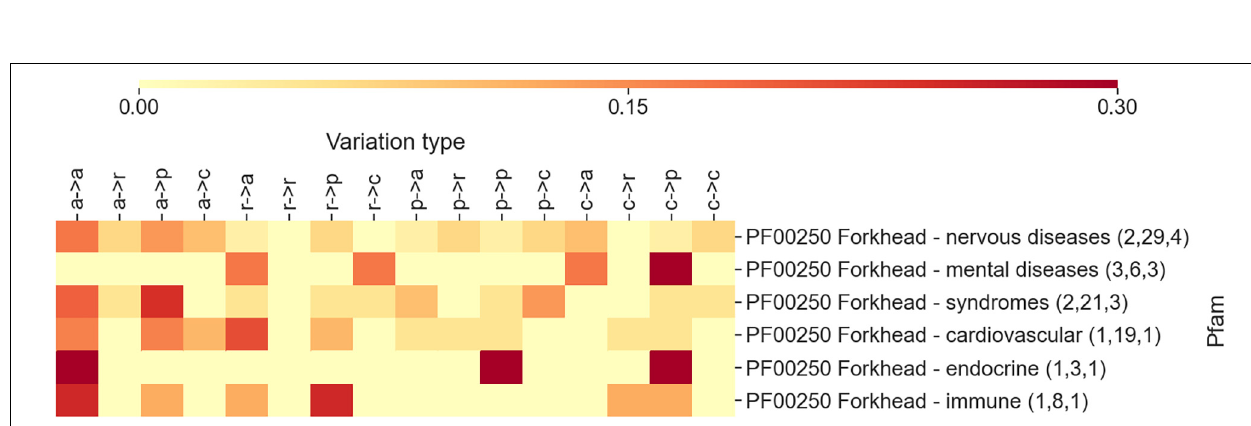
FIGURE 4 | The heatmap reporting, for the Pfam entry PF00250 Forkhead, the frequency of each variation type as observed after separating variations according to disease classes. The numbers within parentheses are the number of proteins, the number of disease variations, and the number of Online Mendelian Inheritance in Man (OMIM) diseases associated with the Pfam (and covered by DOID),